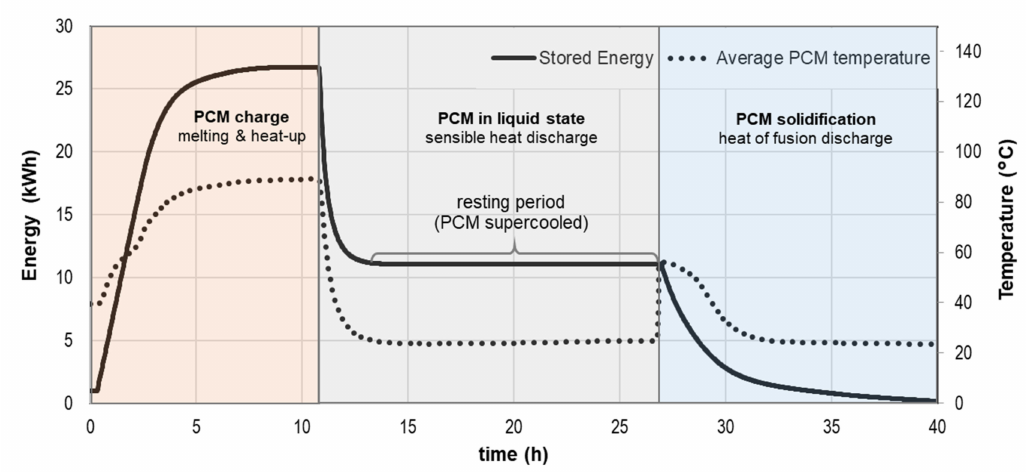
Figure 23. Temperature profile of a test cycle with supercooling of PCM (device “DTU full scale”).